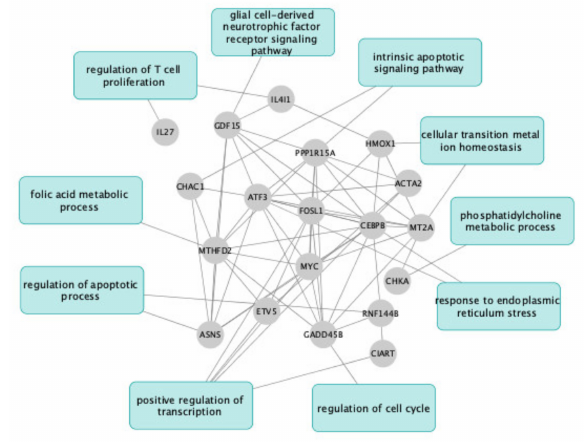
Figure 3. Nineteen common genes differentially regulated by both UDCA versus albumin and TUDCA versus albumin and gene ontology biological process . Differential analysis was performed on UDCA vs. albumin and TUDCA vs. albumin. Differentially expressed genes were selected with FDR < 0.05 and logFC > 0.5. 19 genes were in common between these two analyses. A network was constructed with StrinDB to connect those genes. Then Enrichr was used to select the most regulated pathways for those genes. Finally, the graph was created with Cytoscape tool.